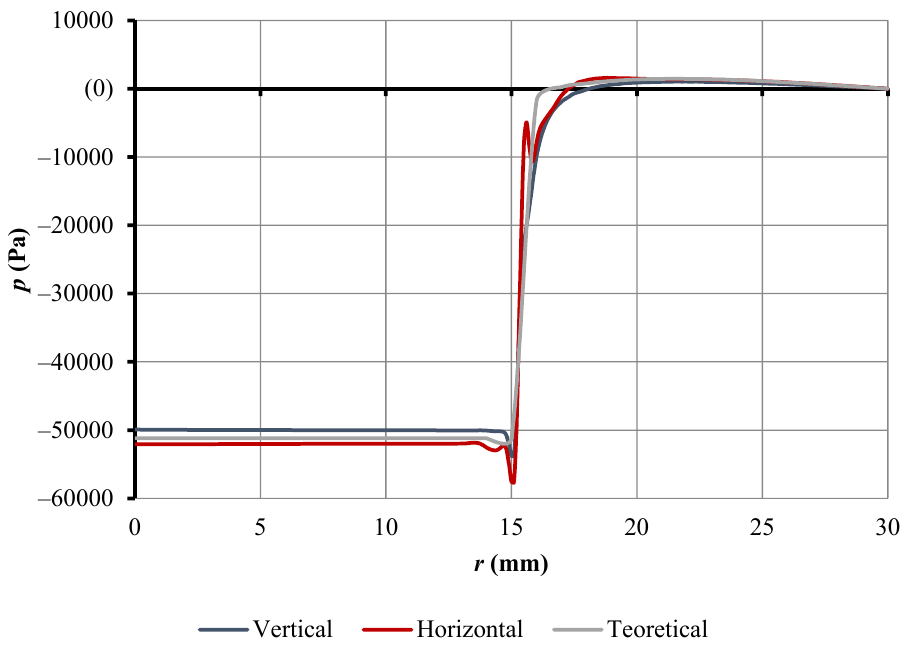
( b ) Figure 7. Pressure distribution on the plane of symmetry of a BGD: ( a ) inlet vertical; ( b ) inlet hori- zontal. By observing the pressure distribution over the BGD symmetry plane, it is obvious that at in a vertical inlet (Figure 7a), the compressed air loses some of its energy in the act of leaking from the conical insert into the chamber of the gripping device. But, with a horizontal inlet (Figure 7b), the compressed air enters directly into the chamber of the